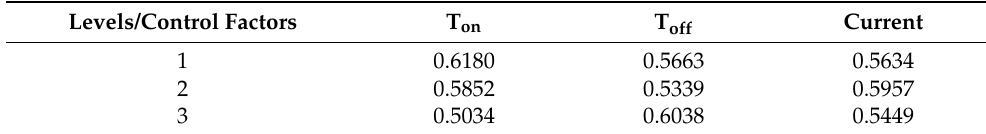
Table 5. Factor response table of